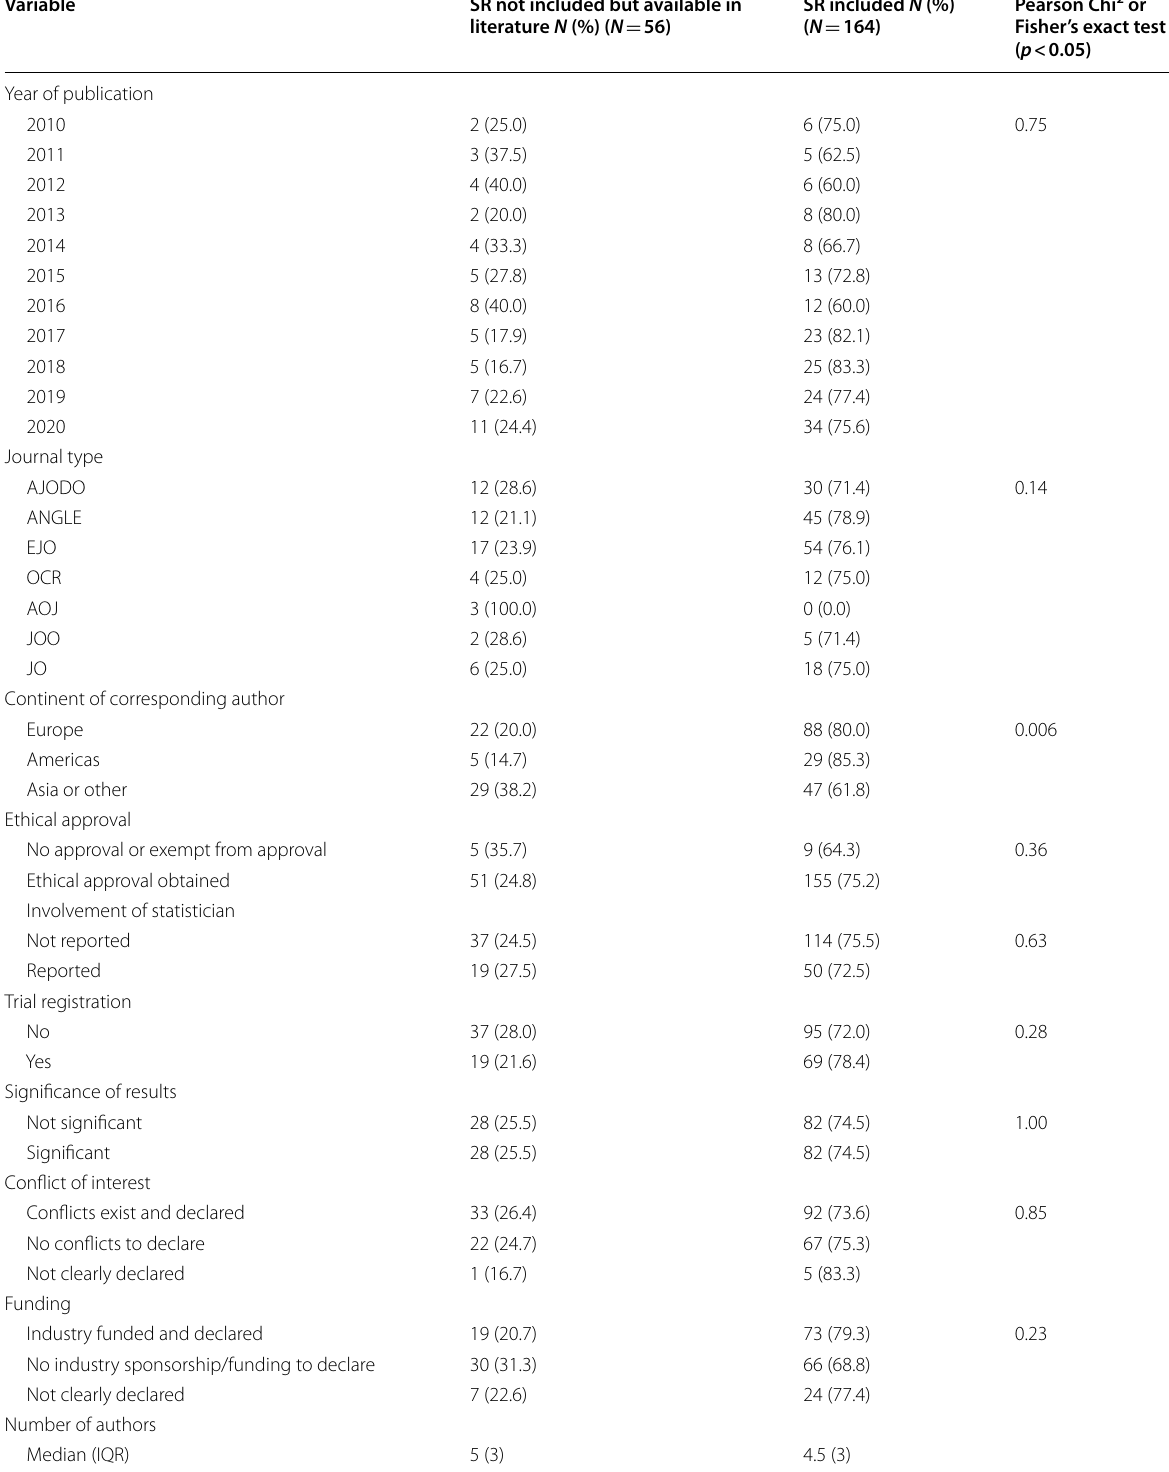
Table 2 The characteristics of trials which included SR in the introduction or not included when there was a SR available in